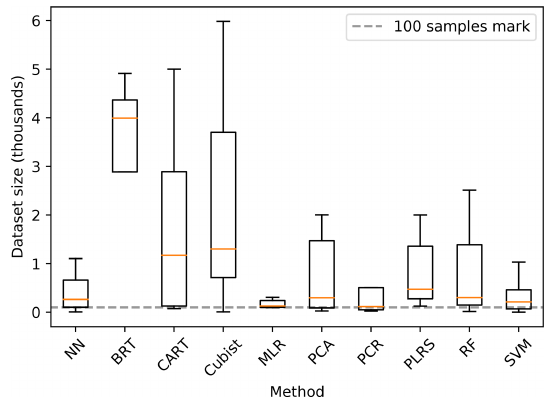
Figure 11. Boxplot of reported dataset sizes grouped by method. Outliers were